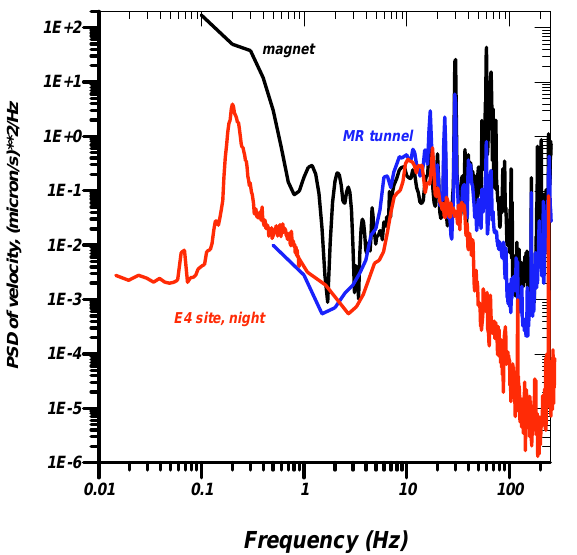
FIG. 8. (Color) Coherence of vertical ground motion signals measured by probes 0 and 62 m apart in E4R and 296 m apart in the Tevatron